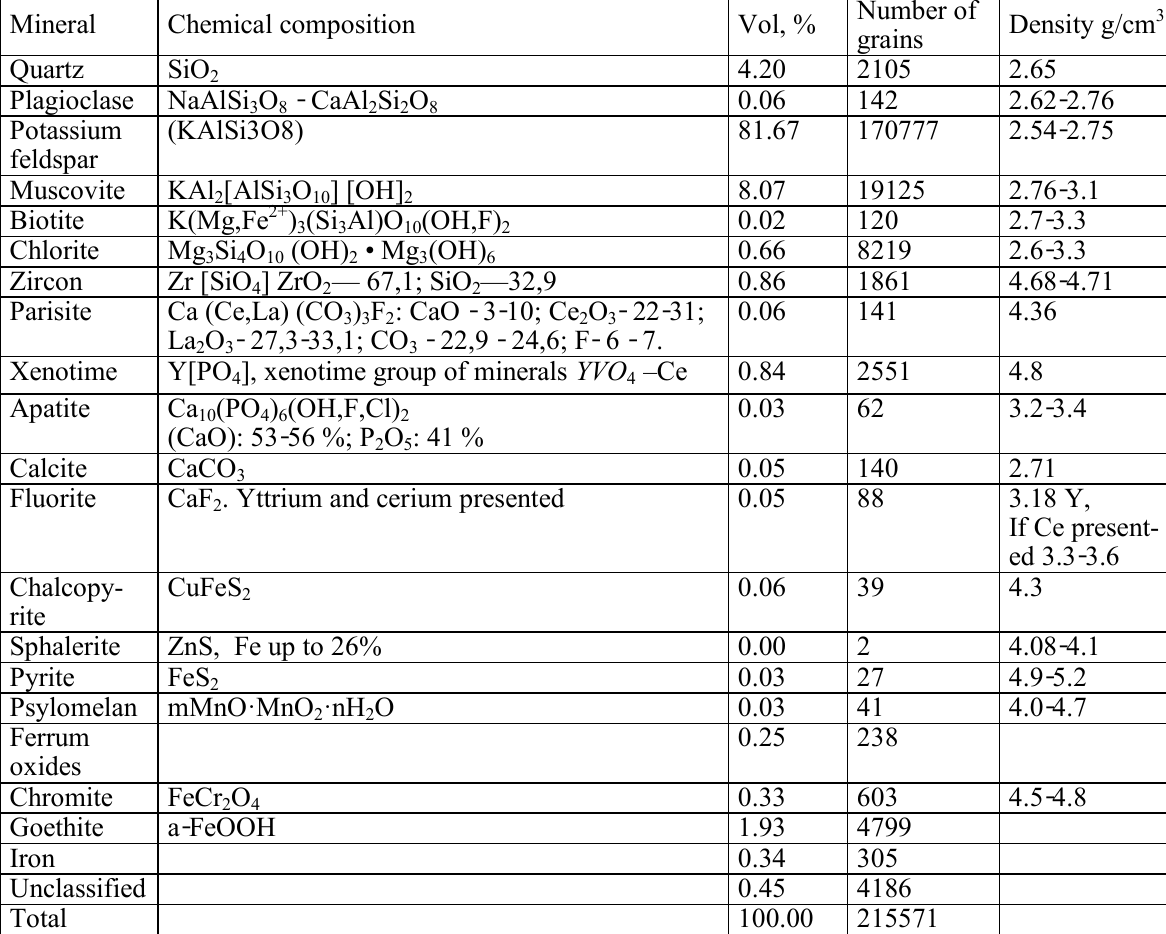
Fig. 16. Xenotime and zircon distribution, А. General view on grains attacked by X-ray beam, B.Xenotime (Y) and zircon (Zr) Table 3. Mineral composition of selected rocks sample